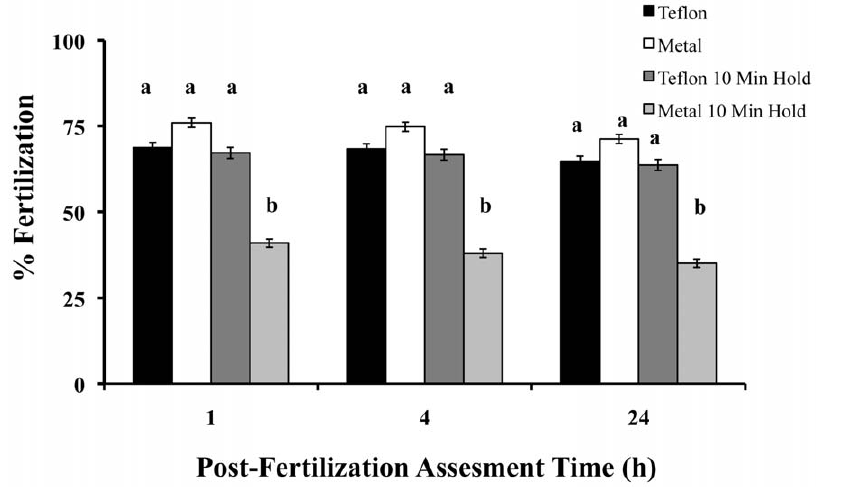
Figure 5. Factors increasing egg-holding time. To determine whether egg handling might have decreased the fertilization success observed in Fig. 4, eggs were handled with either the standard metal spatula or a Teflon-coated spatula. Eggs from individual females (N=10) were initially divided in half with the Teflon-coated spatula, and then each half was divided again with either the Teflon-coated spatula or the metal spatula. Each quarter was moved into separate dish with the assigned spatula and covered in 40 m l of HBSS. One group of Teflon-moved and one group of metal- moved eggs were allowed to sit for 10 minutes before fertilization, while the remaining two groups were immediately fertilized by removing the HBSS and then fertilizing with pooled sperm (N=5 males). Fertilization success was assessed at 1, 4 and 24 h. If the eggs were fertilized immediately, it did not matter what kind of tool was used to move the eggs, the fertilization success was unaffected (P . 0.05). However, after moving the eggs with a metal spatula and waiting 10 min, there was a 50% loss in fertilization success. In contrast, there was no loss of fertilization success after moving the eggs with a Teflon-coated spatula and waiting 10 min (P , 0.05; ANOVA). This suggested that a holding time of 10 min does not impact the fertilization success, and the reduction of fertilization success observed after a 5 min holding time in Experiment 4 was attributed to the egg handling.